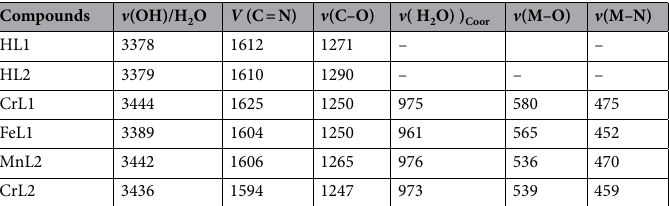
Table 2. IR spectral bands of the new Cr(III), Mn(II), and Fe(III) complexes and their ligands at 4000– 400 cm −1 .